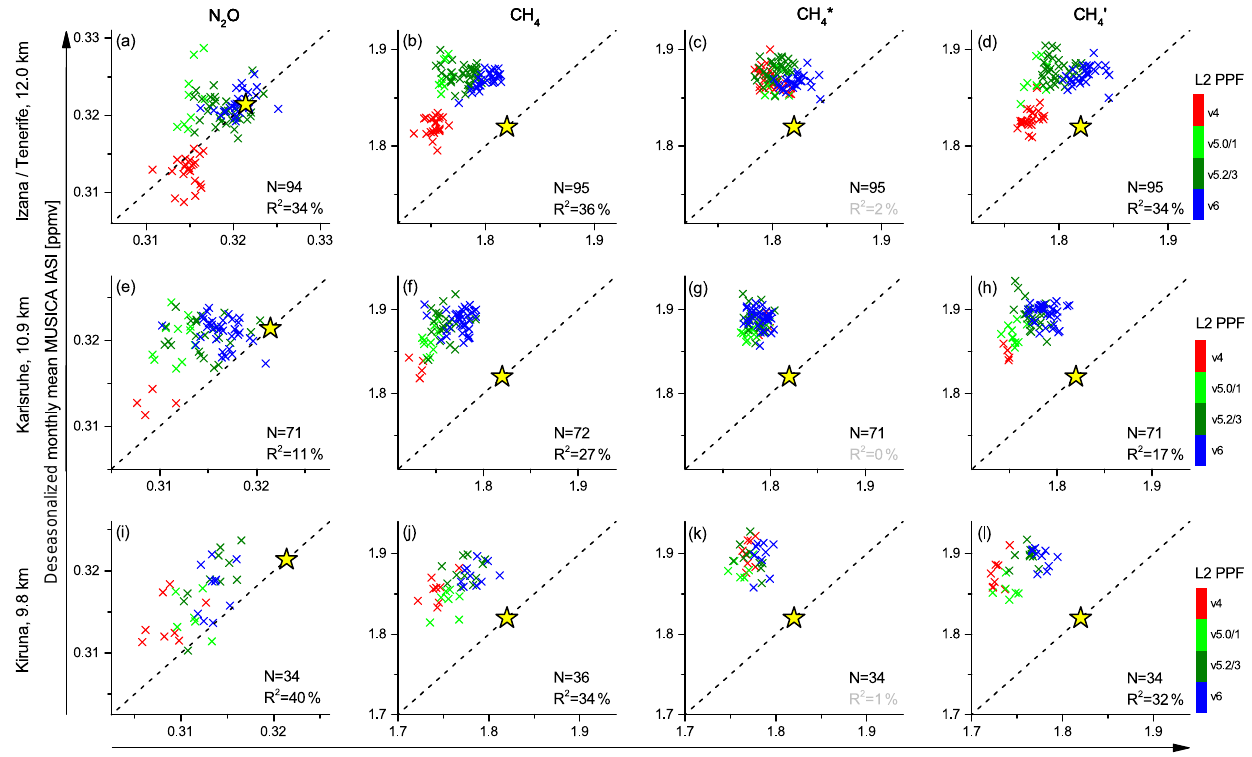
Figure 18. Same as Fig. 17, but for correlations at altitudes representing the UTLS regions.